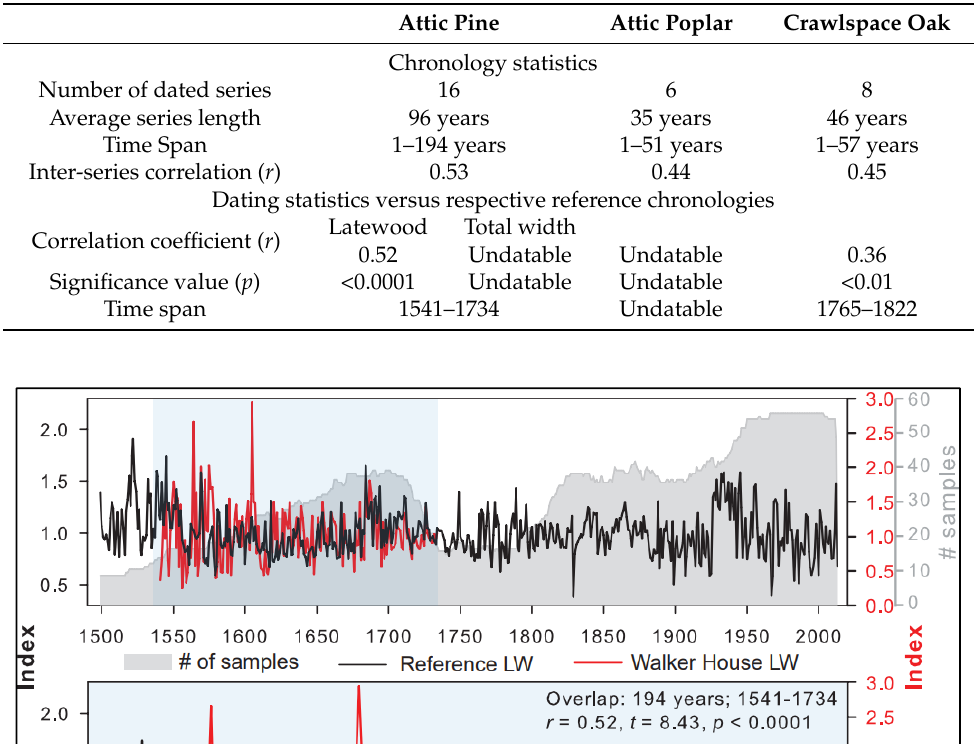
Table 1. Diagnostics and dating statistics for each of the Walker House chronologies.